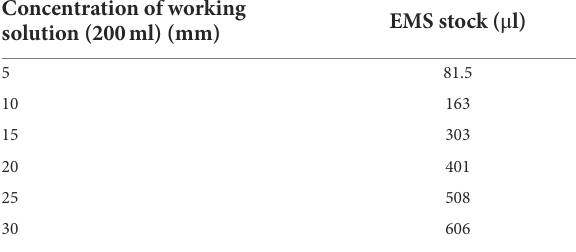
TABLE 1 Preparation of EMS solutions (200 ml) for mutagenesis. Concentration of working solution (200 ml)